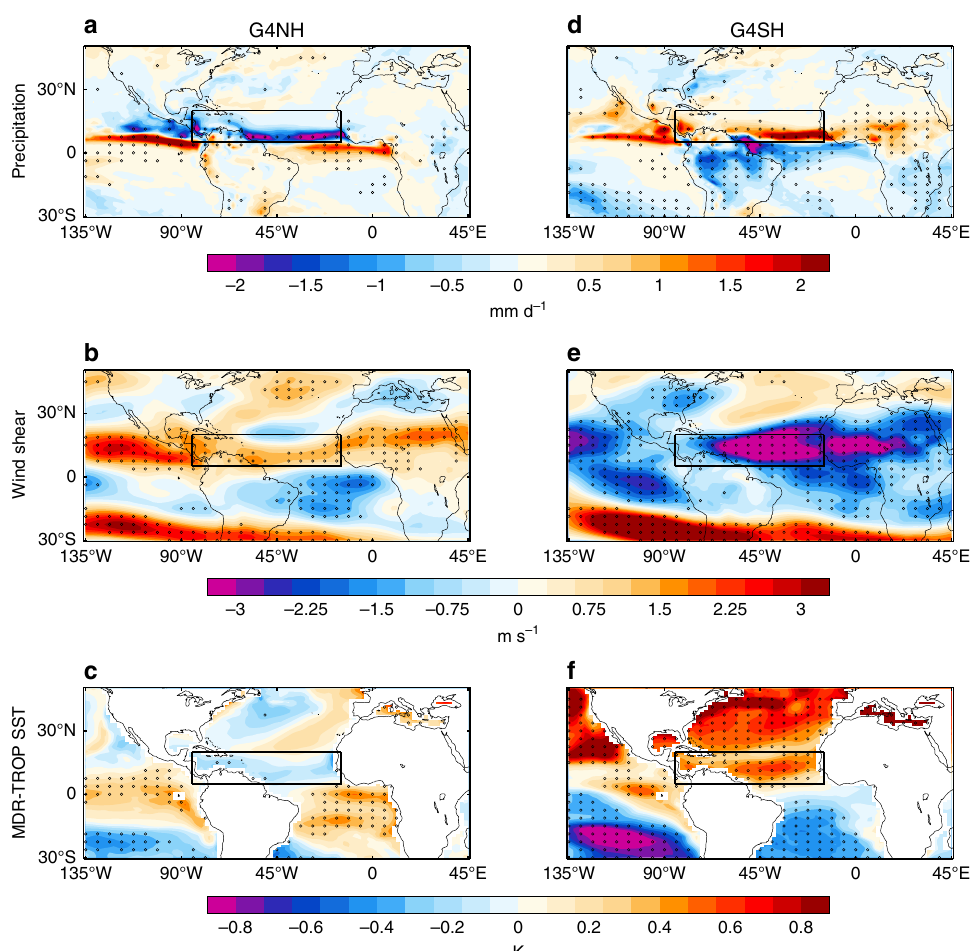
Fig. 6 Climate anomalies in the hemispheric solar geoengineering simulations. a Northern hemisphere only solar geoengineering (G4NH) 2020 – 2070 JJASON precipitation anomaly relative to 1950 – 2000. b The same as a but for vertical zonal-wind shear. c The same as a but for relative SST. d – f The same as a – c but for southern hemisphere only solar geoengineering (G4SH). Stippled regions on the maps show where differences are outside the 90% variability of a 240-year pre-industrial control ensemble mean. The hurricane main development region (MDR, (5° – 20°N, 15° – 85°W)) is marked by black